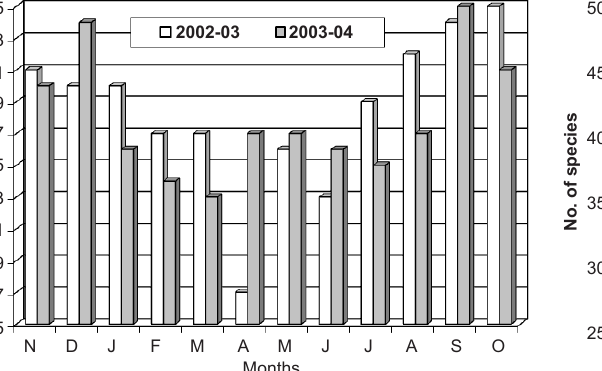
Figure 1. Monthly variations in species richness of phytoplankton of Utra Pat